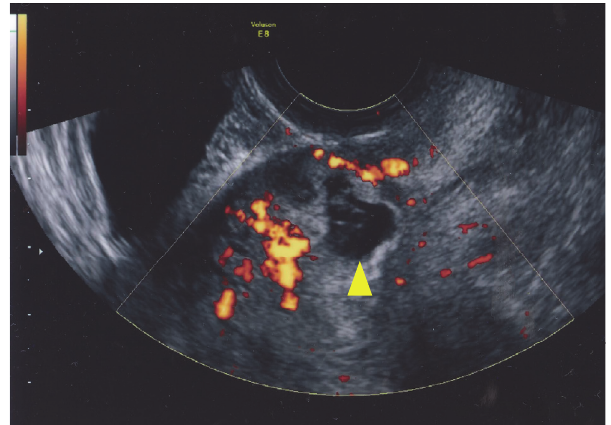
Figure 3: Transvaginal sonographic imaging. A midline sagittal view presenting the gestational sac at the uterine scar of a previous caesarean section and empty uterine cavity (power Doppler study). Triangle indicates the gestational